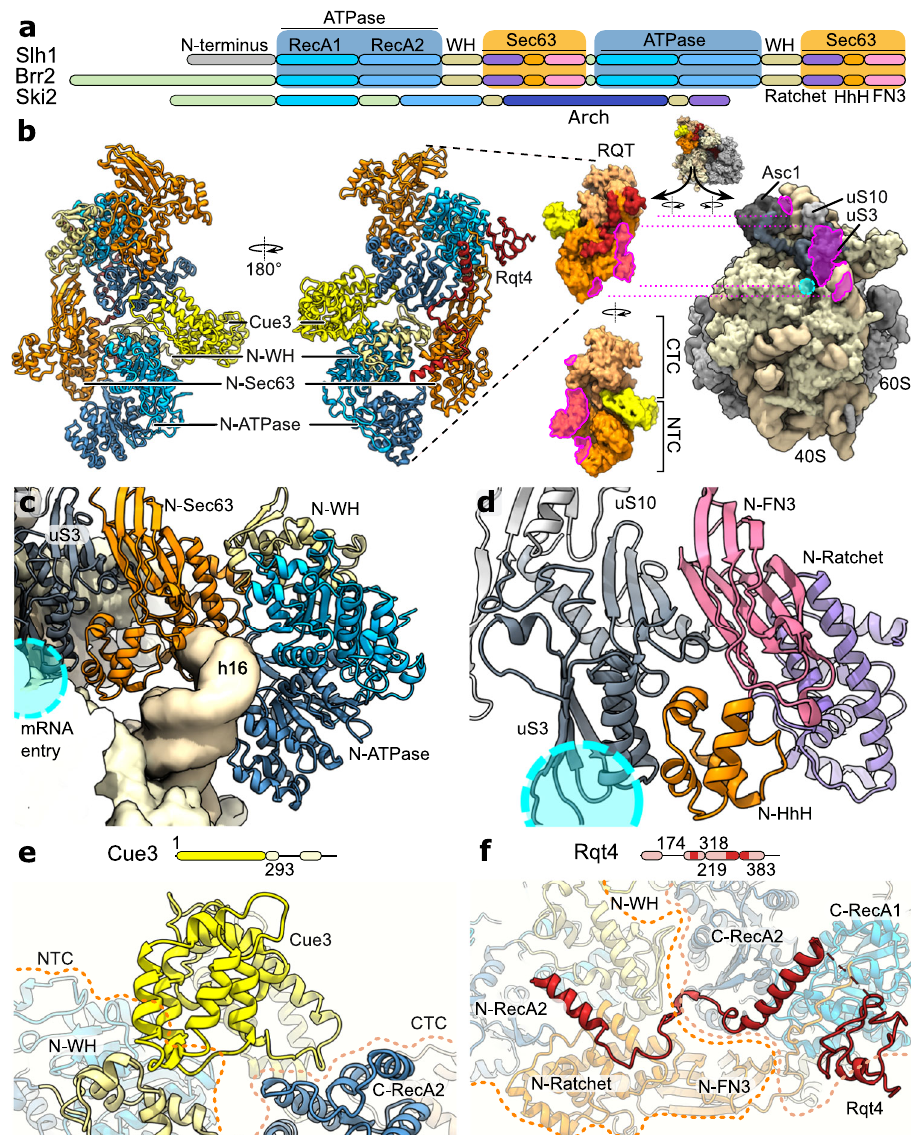
Fig.3|Molecularmodelofribosome-boundRQT.a DomainarrangementofSlh1 and closest homologs Brr2 and Ski2. Slh1 was completely modeled except for the N-terminus (gray). RecA1, RecA2 = RecA-like ATPase domains, WH = winged helix domain, Sec63 = Sec63-like domain (subdivided into Ratchet-, helix-hairpin-helix (HhH)and fi bronectintypeIII(FN3)domains). b MolecularmodelofRQTboundto the 80S ribosome in C1 state. On the right side RQT and the 80S ribosome were convertedtolow-pass fi ltereddensityforclarity.RQT-ribosomeinteractionregions are highlighted in violet. The mRNA entry site is marked as a blue